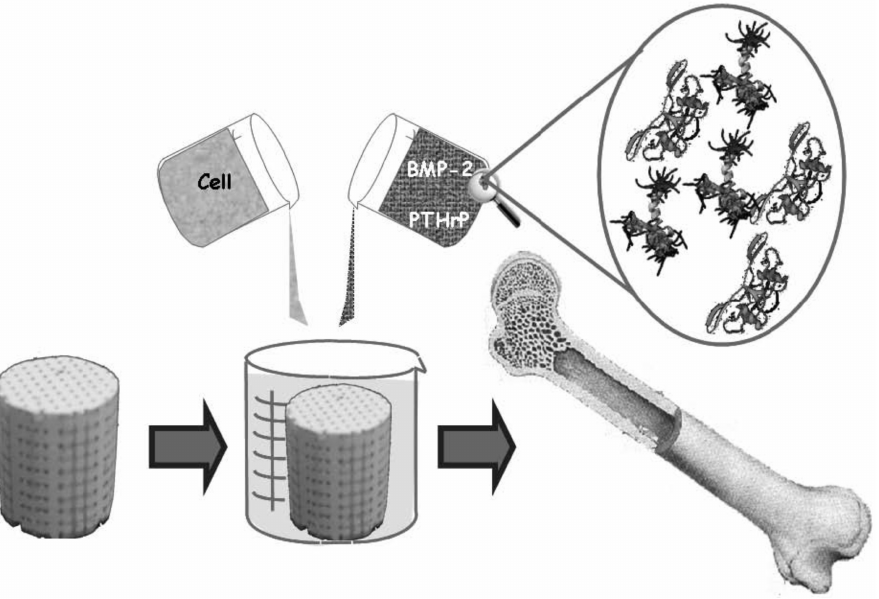
Figure 21. A schematic view of a third-generation biomaterial, in which porous CaPO 4 bioceramic acts as a scaffold or a template for cells, growth factors, etc. Reprinted from Ref. [47] with